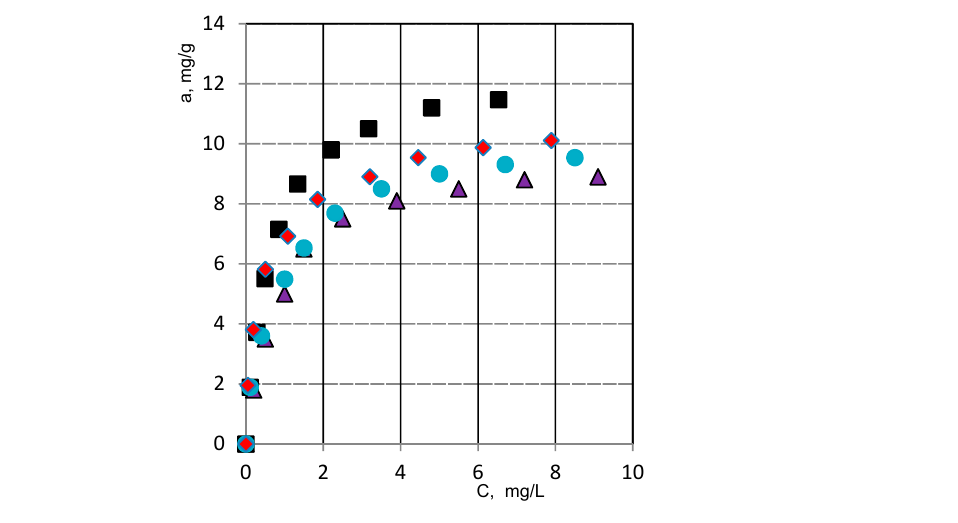
Figure 14. Diazepam adsorption isotherm on Na-montmorillonite from SIF without and with ethanol pH = 6.80 ± 0.05; T = 37.0 ± 0.1 °C; ■ SIF without ethanol; ◆ SIF with 5% ethanol; • SIF with 10% ethanol; ▲ SIF with 15% ethanol.